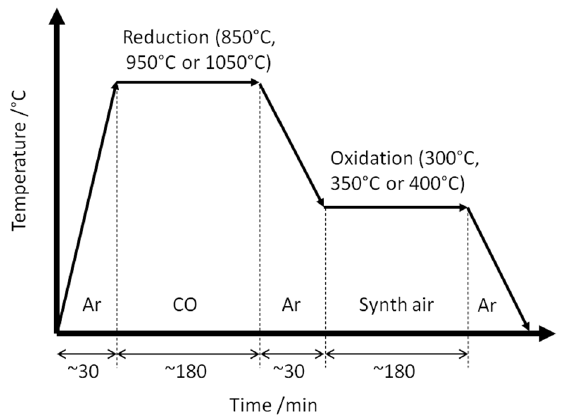
Figure 2. Diagram of the reduction and oxidation process of mill scale realized during thermal analysis.